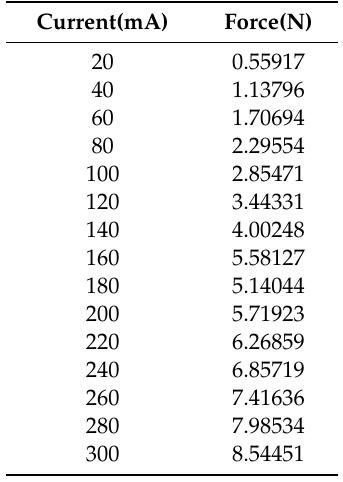
Table 3. Force–current relationship of